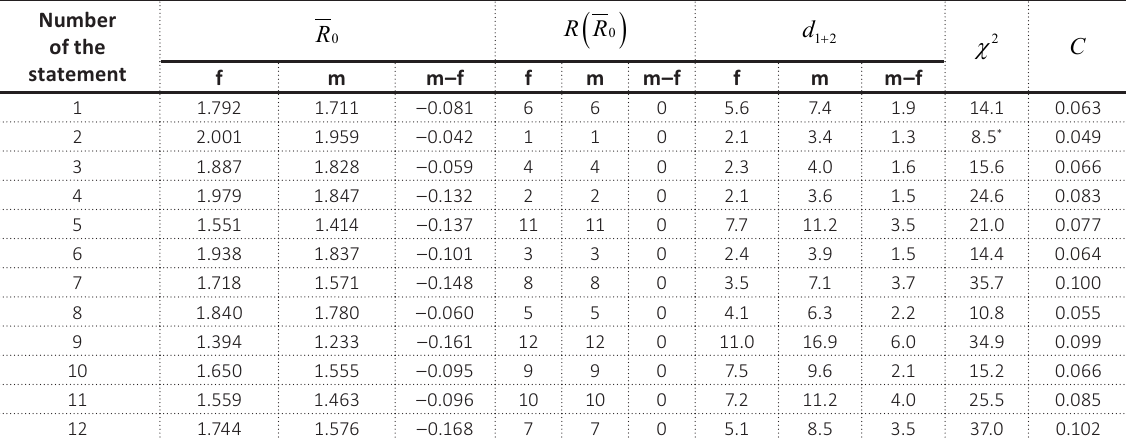
Table 1. Attractiveness of the different aspects of running a